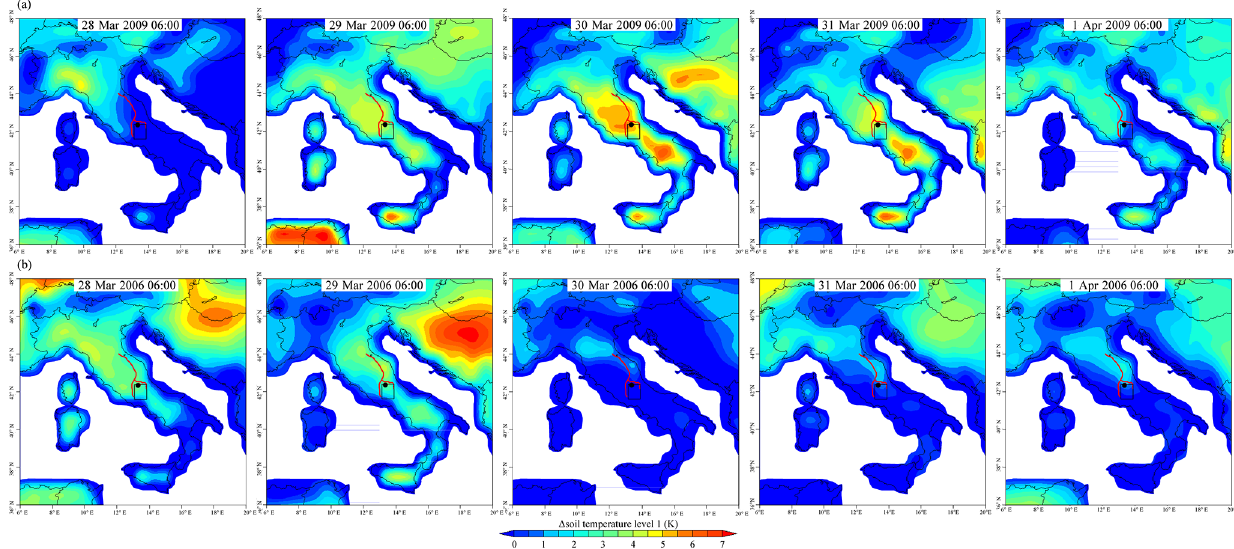
Figure 4. Spatial distributions of deviated soil temperature level 1 ( (cid:49) STL1) at 06:00UTC from 28 March to 1 April 2009 (a) and 2006 (b) , respectively. The black spot indicates the epicenter of the mainshock, the black rectangular box indicates the epicenter pixel, and the red line indicates the related main fault